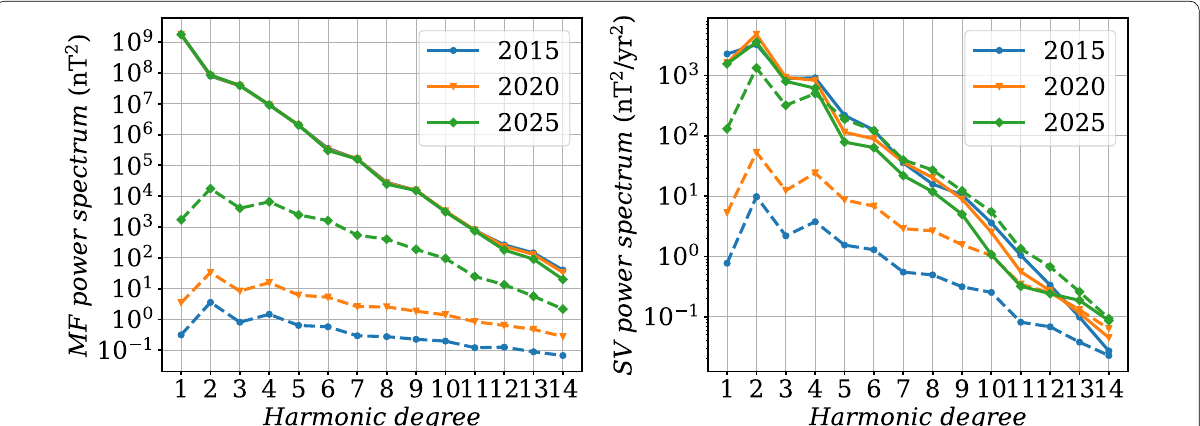
Fig. 9 MF (left) and SV (right) Lowes spectra (Eq. (3)) at the Earth’s surface for epochs 2015, 2020 and 2025, estimated with the spline-free BLUE (see Methods). In dashed lines the respective spectra for the ± σ spread within the ensemble of models